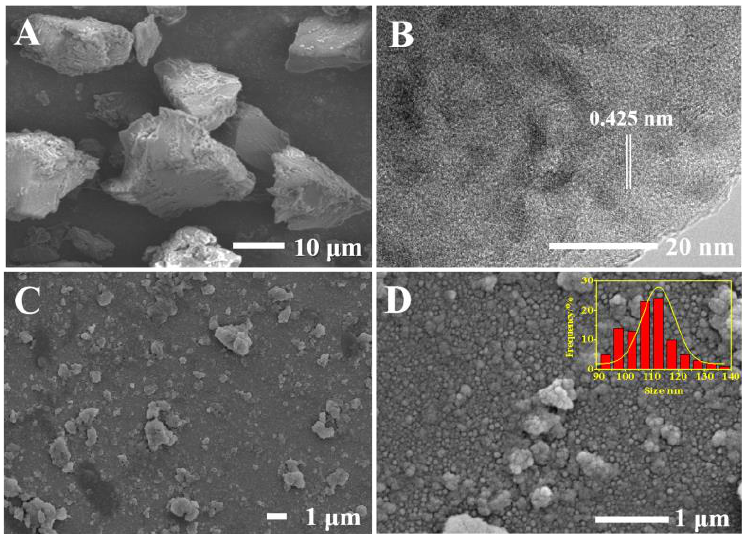
Figure 2. SEM of ( A ) GDY power, ( C ) GDY/GCE, ( D ) GDY/GCE enriched with Bi 3+ , Zn 2+ , Cd 2+ and Hg 2+ (inset was size distribution histogram), and ( B ) TEM of GDY suspension. XPS survey spectrum of GDY was recorded (Figure 3A), which verified that only carbon and oxygen elements appeared. The O 1s peak located at 531.6 eV could be attributed to the absorption of oxygen and slightly oxidization of terminal alkenyl group of GDY. The high-resolution asymmetric C 1s spectrum (Figure 3B) could be deconvoluted into four sub-peaks, including the sp 2 (C=C in benzene rings) at 284.4 eV, sp (C ≡ C) at 285.0 eV, C–O at 286.4 eV and C=O at 288.2 eV, respectively. The binding energy of these sub-peaks are consistent with the reported results [30]. In addition, the largest peak area of C ≡ C indicated that GDY contained a large number of acetylenic bonds, which might provide more active sites for preconcentration of heavy metal ions.